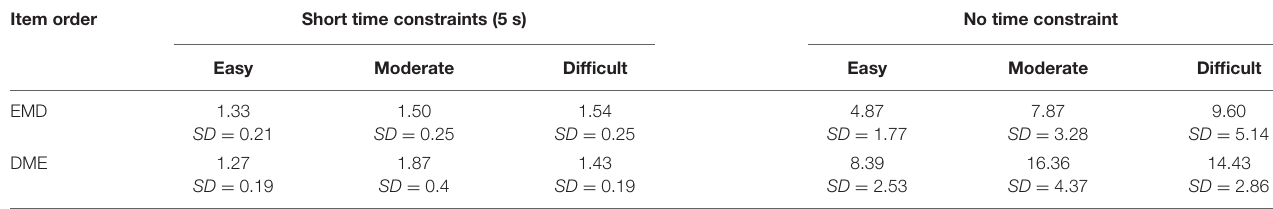
TABLE 1 | Self-paced study time in seconds for Experiment 1 (Ms, SDs). Item